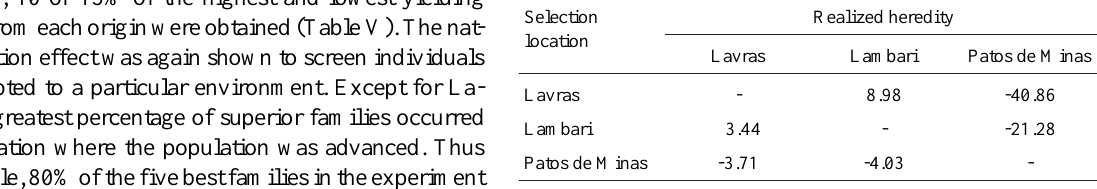
Table IV - Re al ized heritability per cent age ( se lec tion of the ten best fam i lies in Lavras, Lambari and Patos de Minas and their re sponse in the other lo ca tions. Se lec tion lo ca